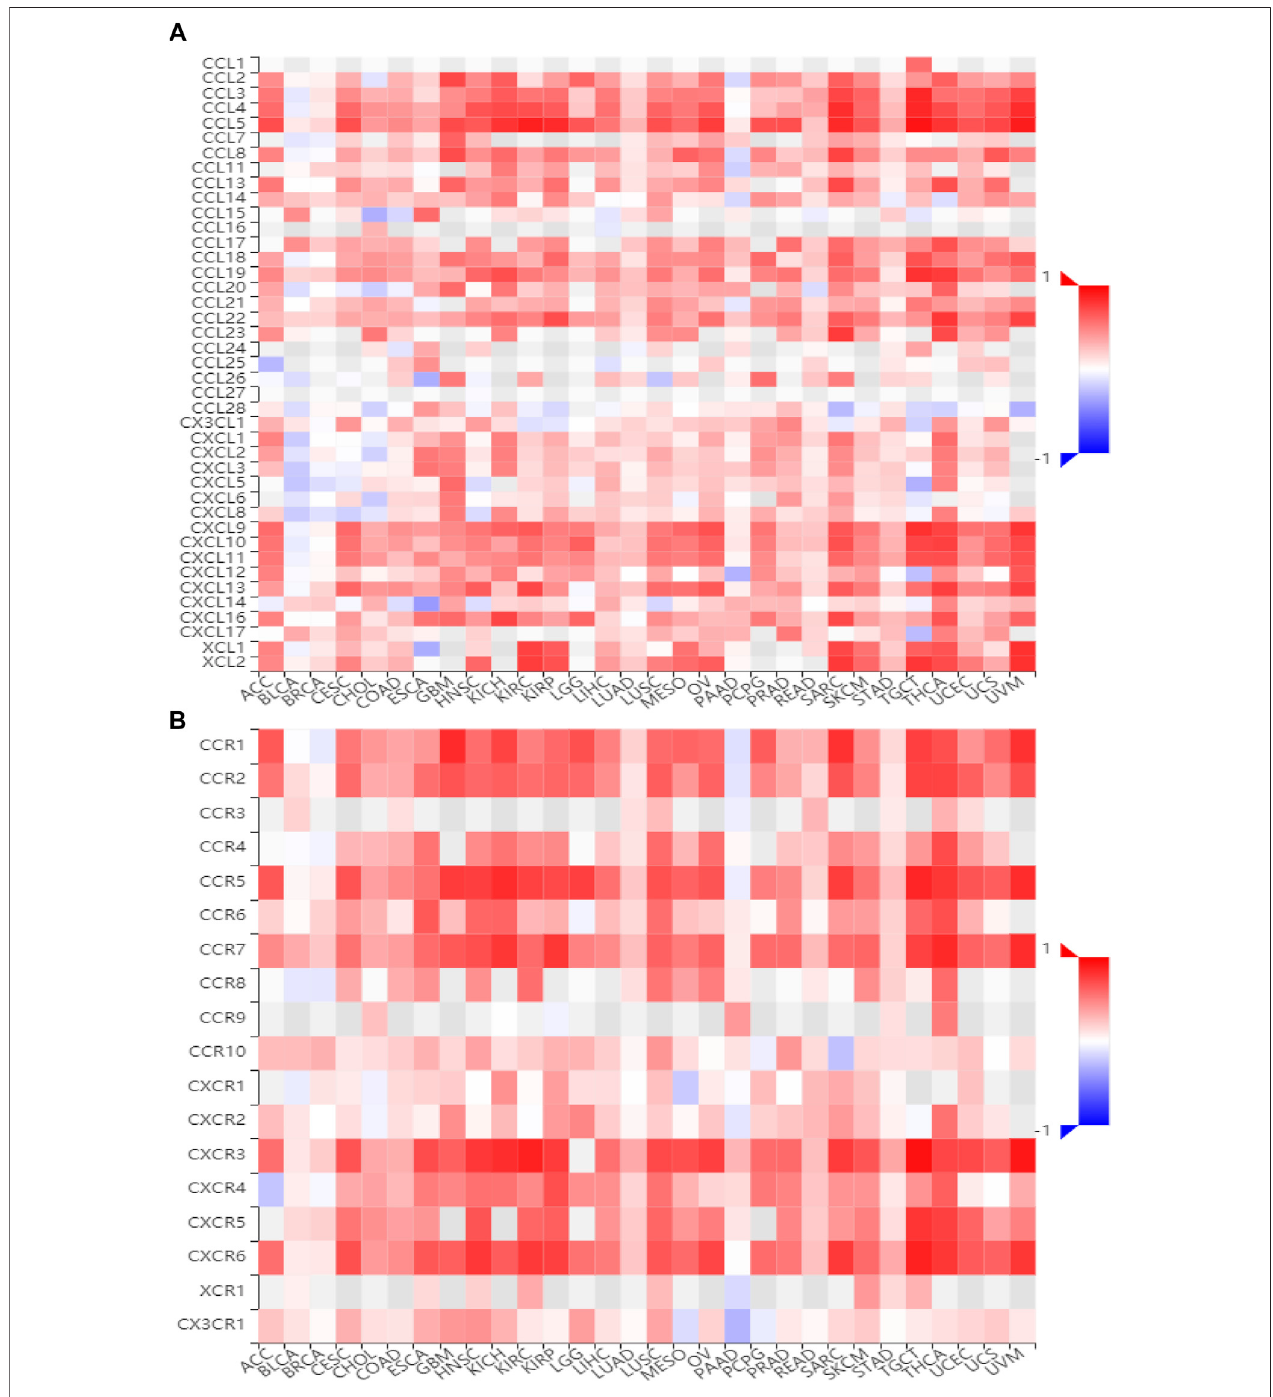
FIGURE 8 | Correlation between BATF and chemokine and related receptor expression. (A) The expression correlation between BATF and chemokines. (B) The expression correlation between BATF and chemokine receptors.